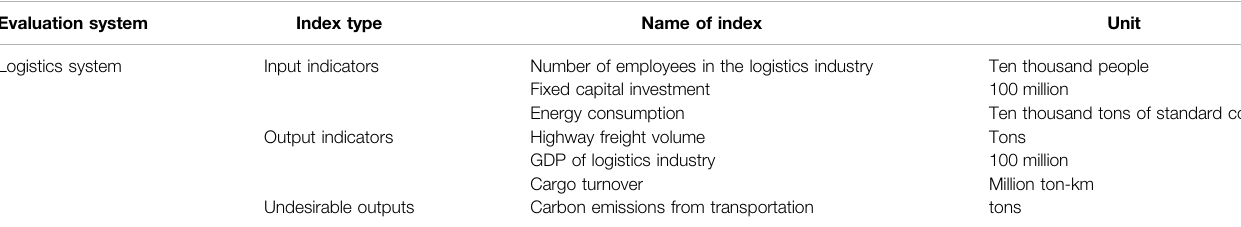
TABLE 2 | Index system of logistics industry ecological ef fi